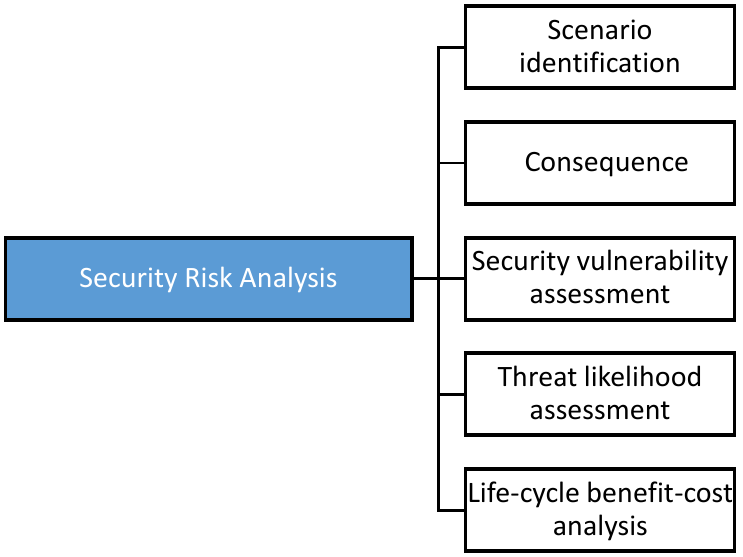
Figure 1 . Five main components of security risk analysis. Figure 1. Five main components of security risk